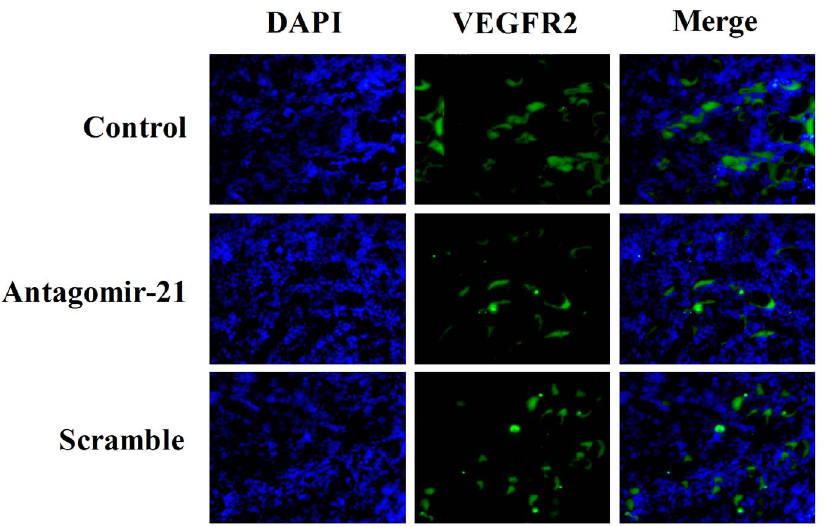
Figure 5. VEGFR2 immunostaining assay of tumor sections from different groups. Representative VEGFR2 immunostaining images were taken under conditions as indicated (original magnification, 6 200). Immunostaining for VEGFR2 was green, cell nucleus was blue. The amount of stationary VEGFR2 staining was significantly lower in the antagomir-21 group relative to control group, while there was no difference between control group and scramble group.